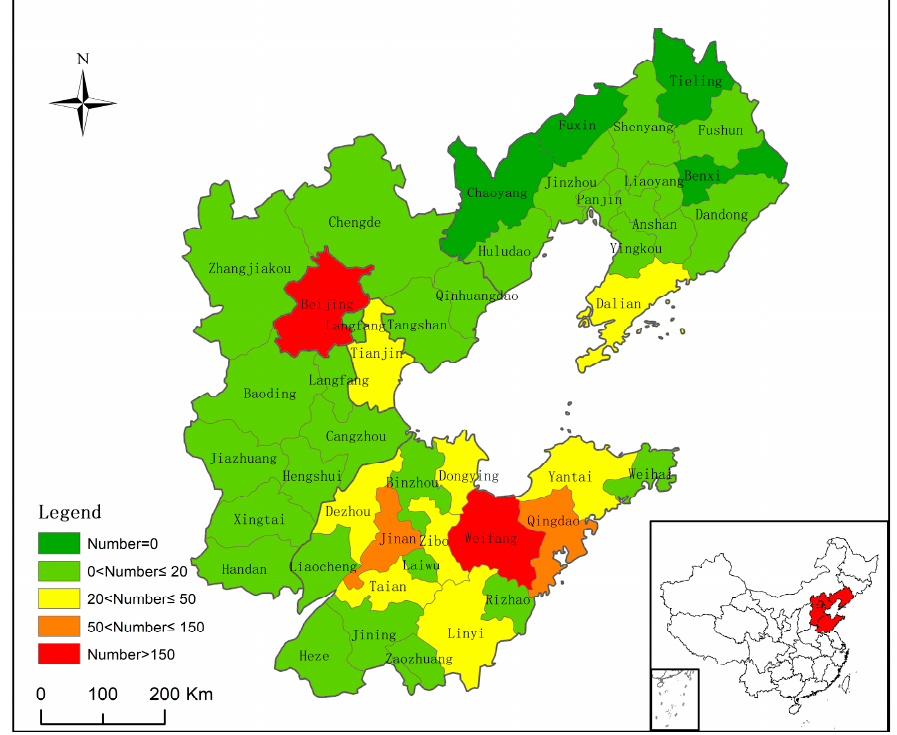
Figure 5. The spatial distribution of Weibo related to the flood on a city level.